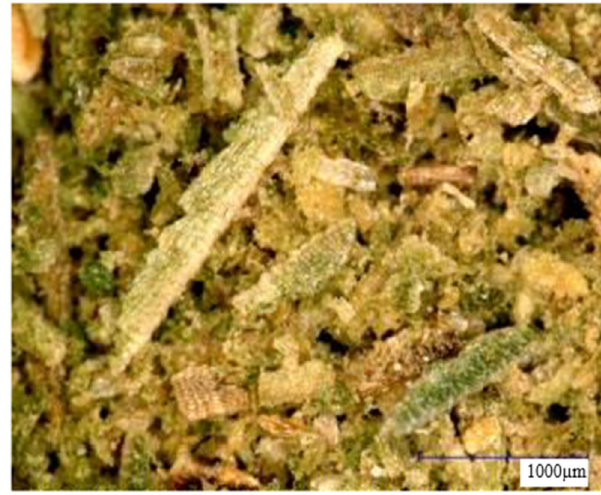
Figure 9. Horsetail (magnification 50 × ).